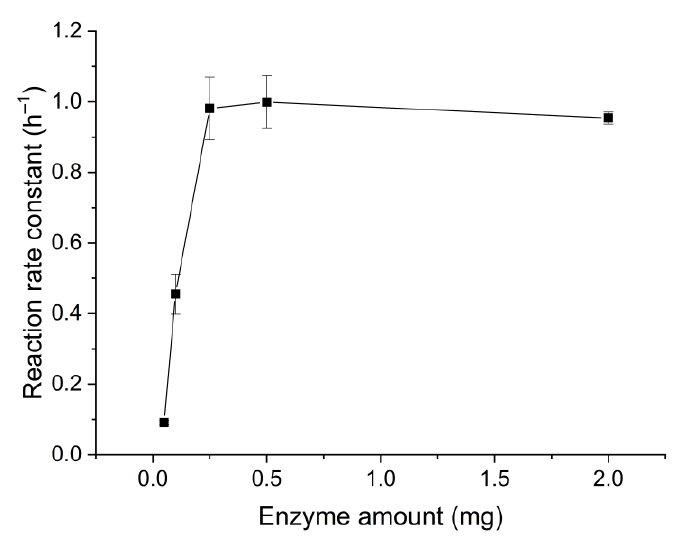
Figure 2. Relation between reaction rate constants and amount of HLADH used.